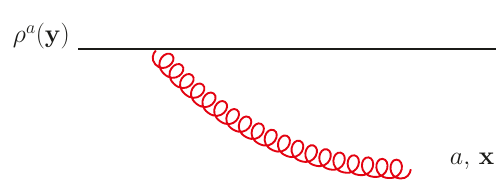
( x ) produced at transverse position x by a color P